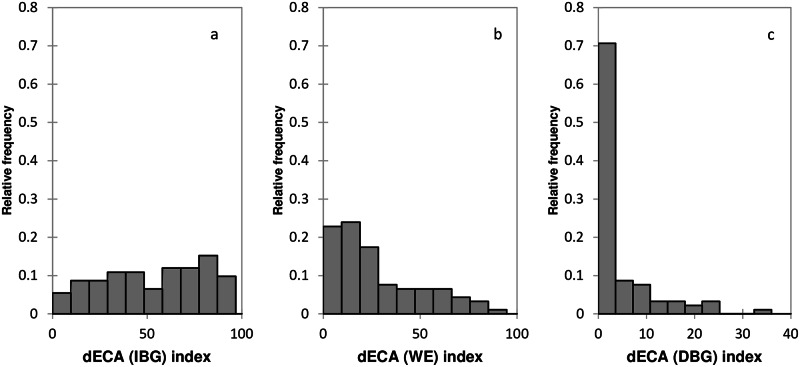
The relative frequencies of summer pasture units (SPU) that lost grassland connectivity caused by a) IBG, b) WE, and c) DGB, as estimated by the dECA index.